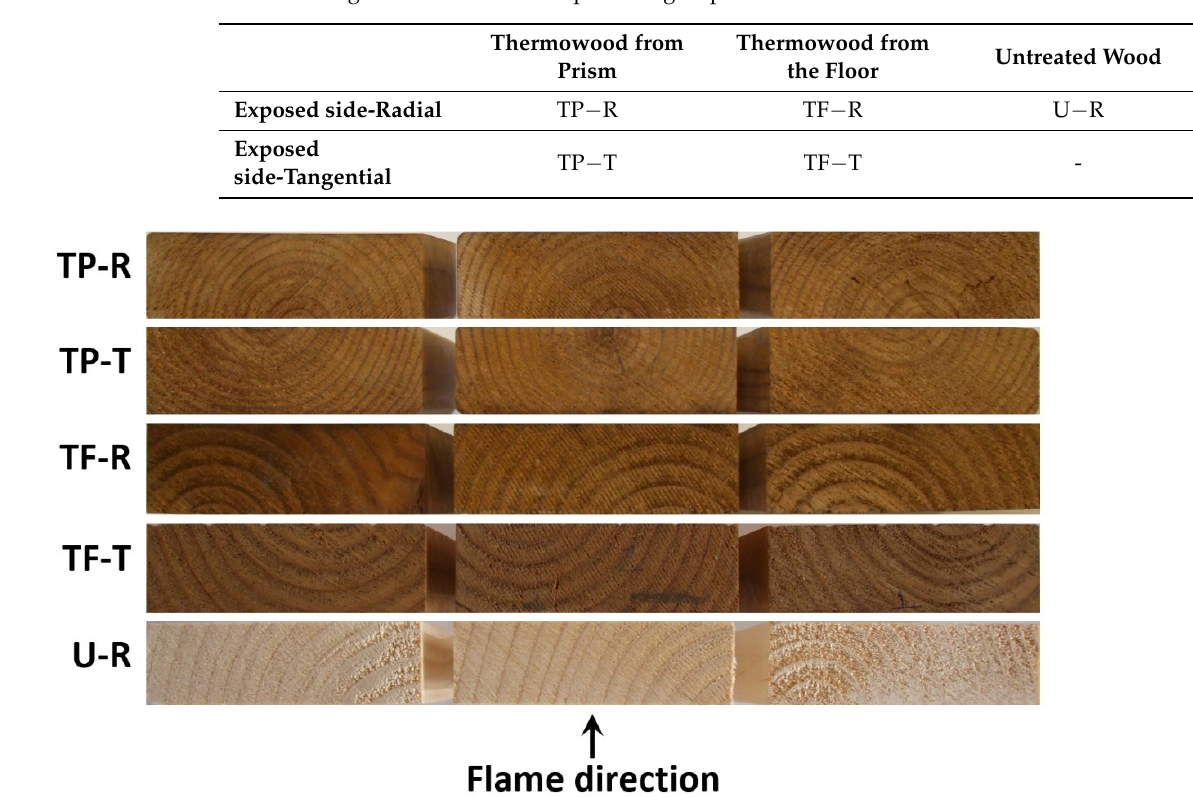
Figure 1. Tested specimens and the direction of flame.